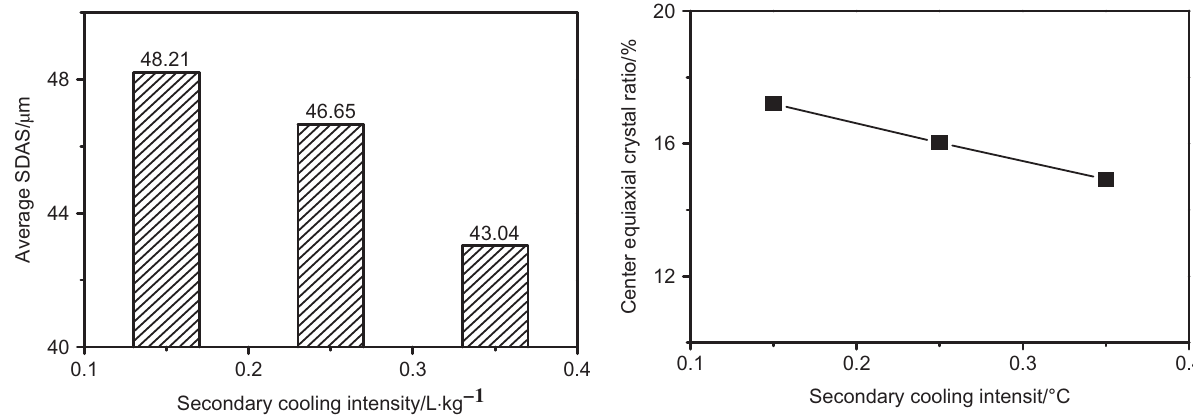
Figure 7: The simulated statistical results of SDAS and equiaxed crystal ratio at different secondary cooling intensities.